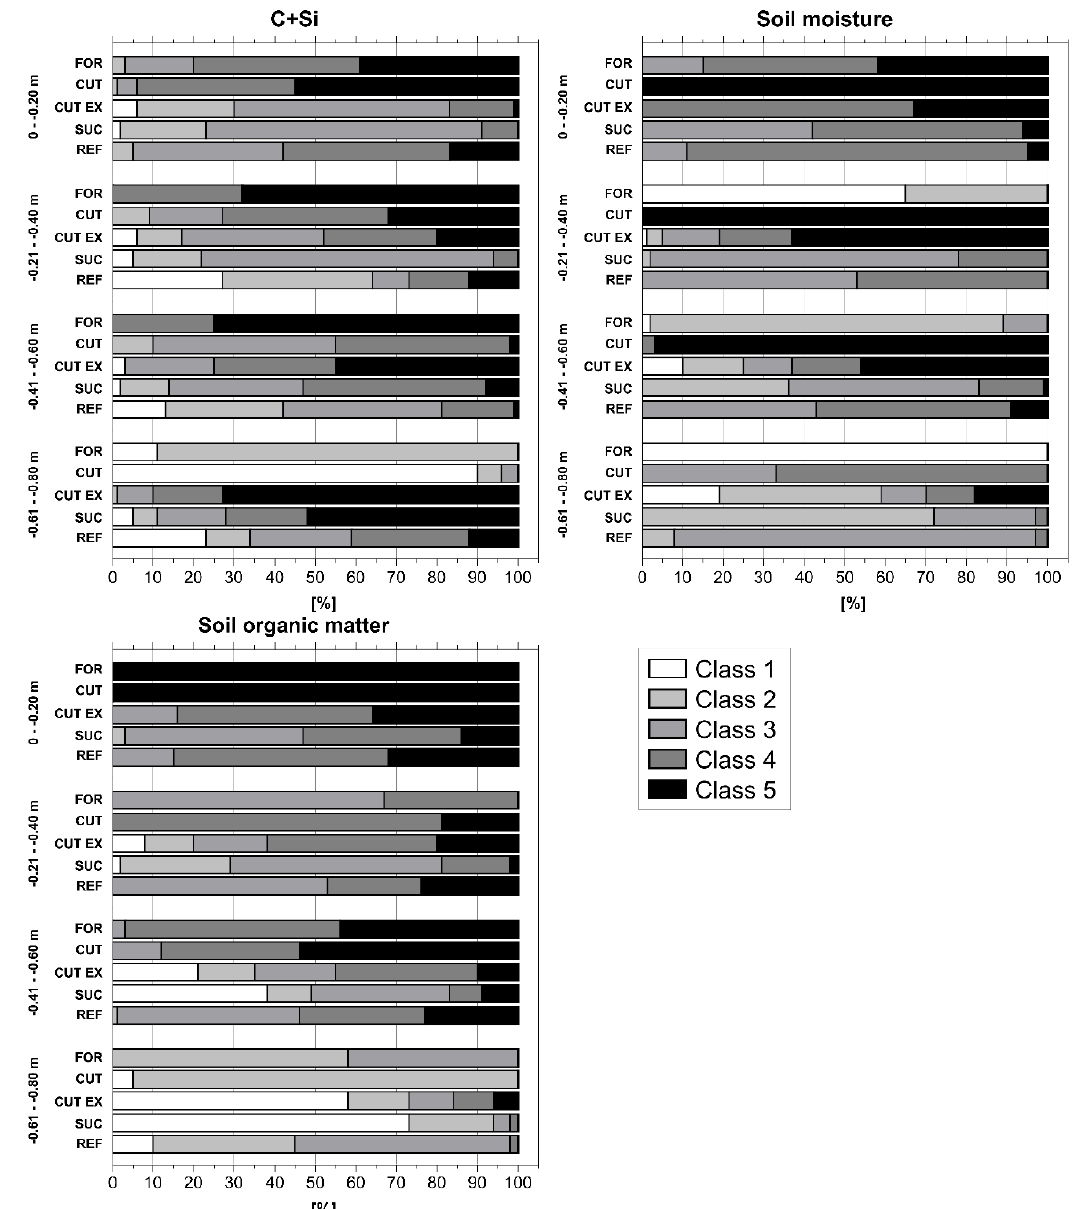
Figure 18. Relative shares of factor-classes used for ANOVA.